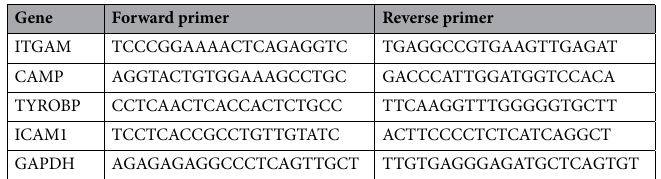
(Takara Bio, Japan). RT-qPCR was then carried out with the resultant cDNA as a template. Hub gene-specific primers used in these experiments were designed by Sangon Biotech (Shanghai, China) and are detailed in Table 3. An ABI Prism 7500 sequence-detection system (Applied Biosystems, USA) using a Taq PCR Master Mix Kit (Takara) was used to perform quantitative RT-PCR was performed using RT Reaction Mix in a total volume of 20 μL with the following reaction conditions: predenaturation at 95 °C for 30 s, then 40 cycles of 95 °C for 30 s and 60 °C for 30 s. Diagnostic criteria. Serum triglyceride (TG; 0.56–1.70 mmol/L), ApoA1 (1.20–1.60 g/L), total cholesterol (TC; 3.10–5.17 mmol/L), apolipoprotein (Apo) B (0.80–1.05 g/L), low-density lipoprotein cholesterol (LDL-C; 2.70–3.10 mmol/L) and high-density lipoprotein cholesterol (HDL-C; 1.16–1.42 mmol/L) and the ApoA1/ApoB ratio (1.00–2.50) levels were defined as their respective normal values at our Clinical Science Experiment Center. The diagnostic criteria of diabetes 20 , hypertension 21 , obesity, normal weight, overweight 22 and hyperlipidemia 23 were based on previous studies. Statistical analyses. All data was analysed with the SPSS (Version 22.0). Continuous data is depicted in terms of mean ± SD. Independent-samples t tests were used to assess the general characteristics differences between controls and individuals with CAD patients and controls. The Chi-square test was utilized to evalu- ate the differences in the amount of alcohol consumers, age distribution and proportion of smokers between controls and individuals with CAD. Referring to previous studies 62,63 , receiver operating characteristic (ROC) curves were built based on plasma levels of ITGAM , CAMP , YROBP and ICAM1 to evaluate the specificity, sen- sitivity, and respective areas under the curves (AUCs) with 95% CI. The optimal cut-off value for diagnosis was investigated by maximising the sum of sensitivity and specificity and minimising the overall error (square root of the sum [1 − sensitivity] 2 + [1 − specificity] 2 ), and by minimising the distance of the cutoff value to the top-left corner of the ROC curve, and the corresponding empirical ROC curve of ITGAM , CAMP , TYROBP and ICAM1 were drawn by a nonparametric method using SPSS software (Version 22.0). R software (version 4.0.0) was used to carry out bioinformatic analysis and heat mapping of the correlation models.